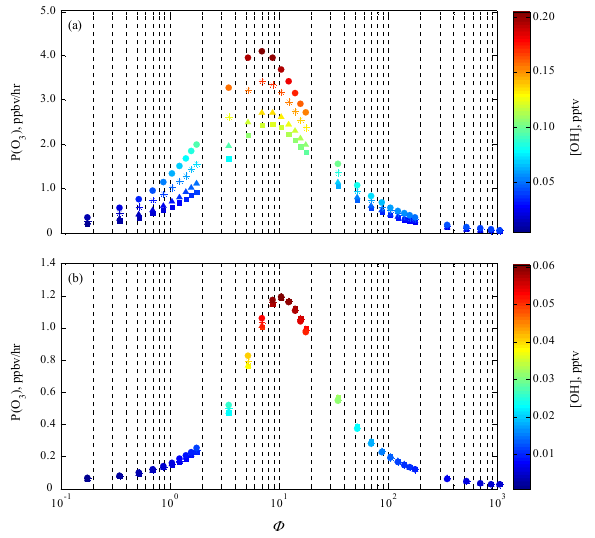
Fig. 8. Dependence of P(O 3 ) on Φ when the relative humidity is constrained to 10% (shown by square), 20% (shown by triangle), 50% (shown by asterisk) and 90% (shown by dot), respectively. The photolysis rates are constrained to those observed at (a) 1150JST and (b) 0600JST of 18 September. The NO/NO 2 ratio and other conditions are constrained to those observed at 1150JST of 18 September. The color of the dots denotes the mixing ratio of OH radical.